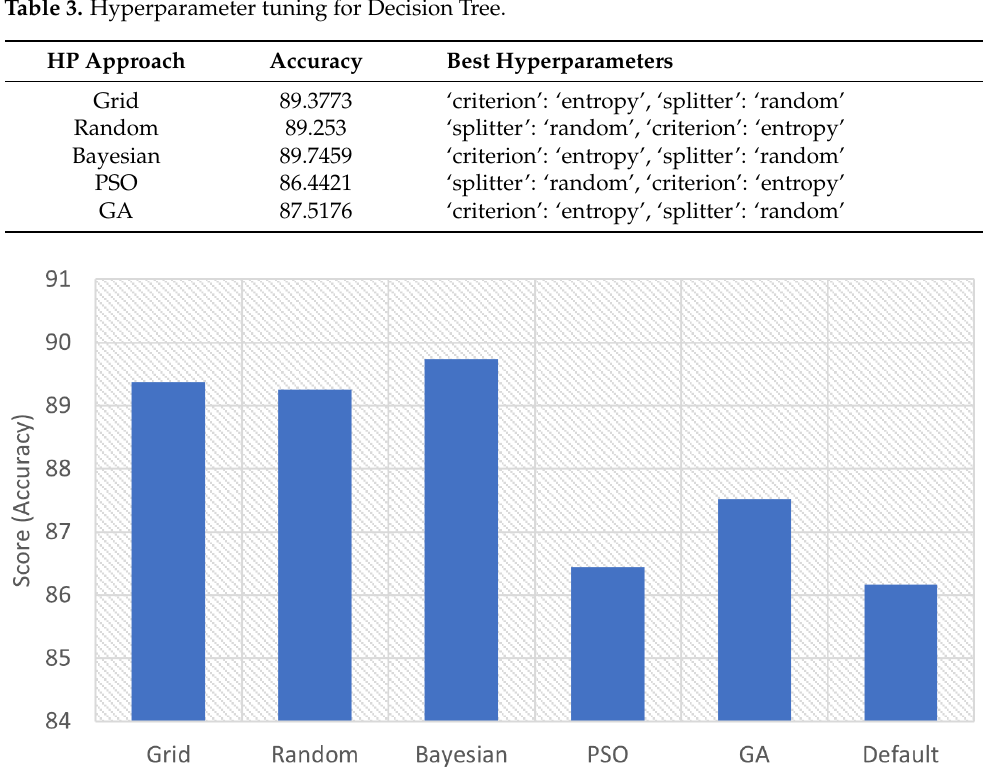
Figure 11. Hyperparameter tuning techniques versus score for Decision Tree (DT).